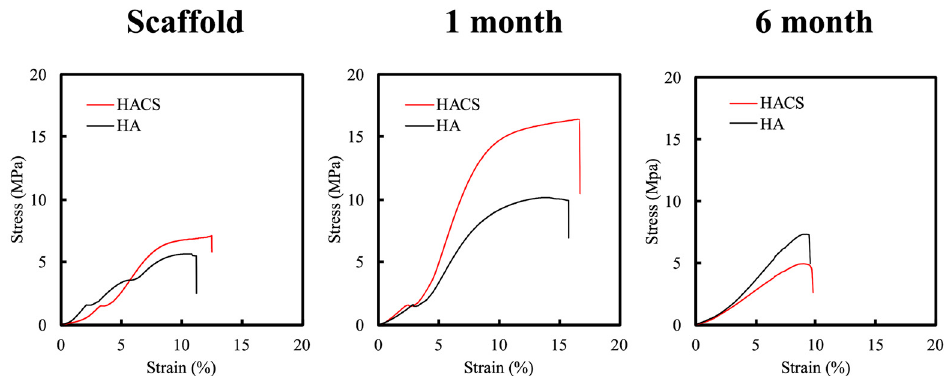
Figure 3. Stress–strain curves of HA and HACS scaffolds before and after immersion in SBF for 1 month and 6 months.